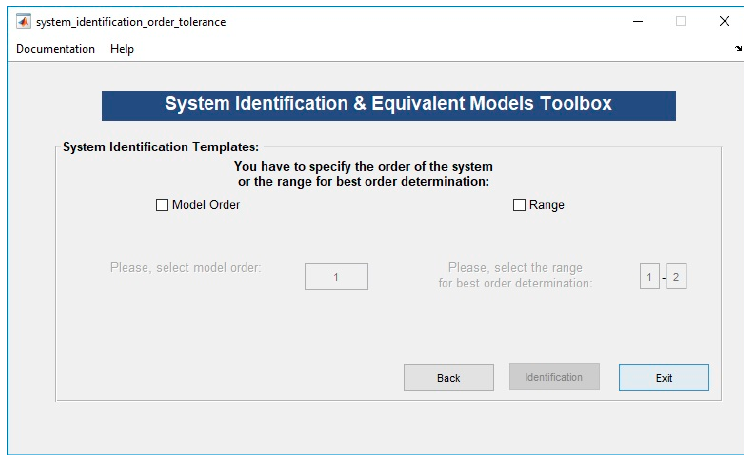
Figure 5. Model order determination window for mode identification method.